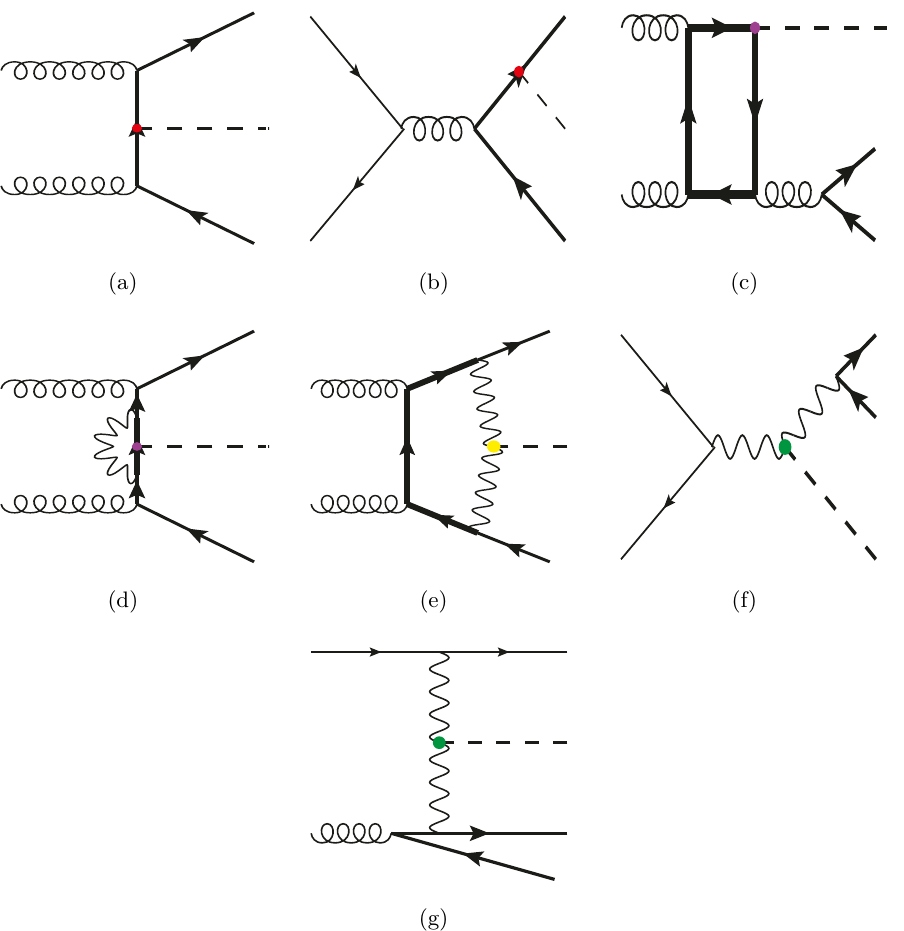
Figure 1 . Representative Feynman diagrams appearing in the complete-NLO calculation for Hb ¯ b production. The thick, medium-thick and thin solid lines represent the top, bottom and light (anti- )quarks, respectively. The dashed lines stand for the Higgs boson, the curly lines are gluons, and the wiggly lines are the weak bosons ( W and Z ). The red/violet/green/yellow bullets represent Hb ¯ b / Ht ¯ t / HZZ / HWW